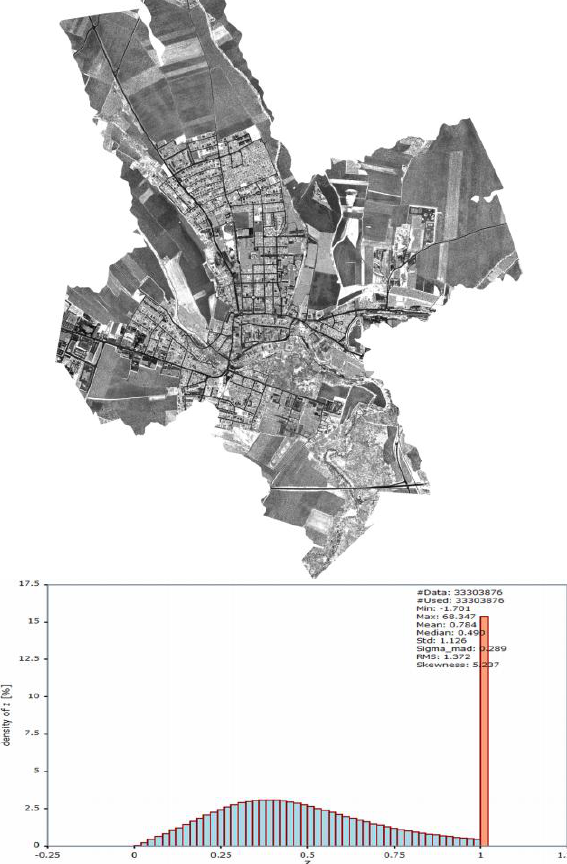
Figure 5. Upper image: Calibrated radiometric reflectance at 1064nm (linear scale from 0 (black) to 1 (white)); Lower image: Histogram of the calibrated radiometric reflectance values.